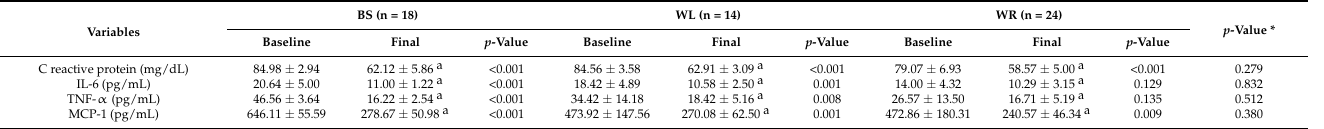
Table 3. Changes in inflammatory cytokines among study groups.